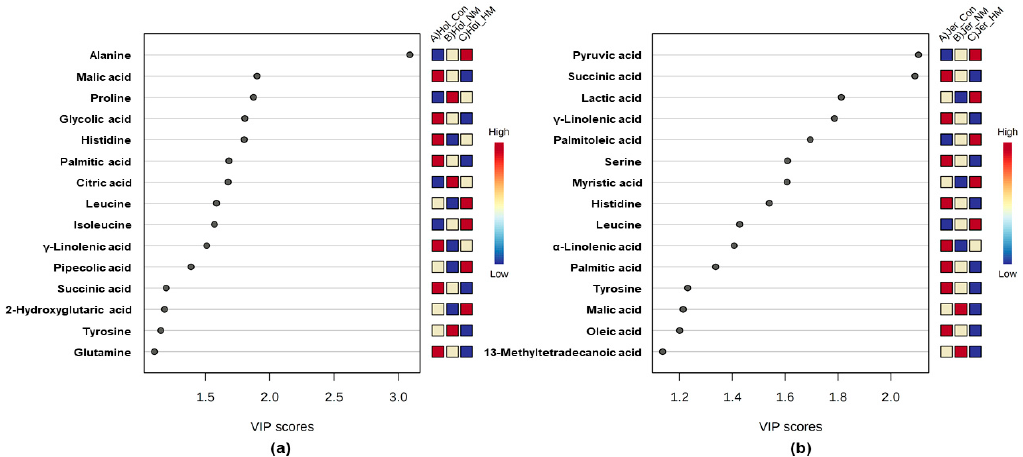
Figure 5. Variable importance analysis of top 15 serum metabolites in Holstein ( a ) and Jersey ( b ) steers supplemented with different concentration of minerals. Hol: Holstein, Jer: Jersey, Con: only TMR (without mineral supplementation), NM: TMR + NRC recommended concentration of mineral supplementation (Se 0.1 ppm + Zn 30 ppm + Cu 10 ppm)/kg DM and HM: TMR + higher than recommended concentration of mineral supplementation (Se 3.5 ppm + Zn 350 ppm + Cu 28 ppm)/kg DM.